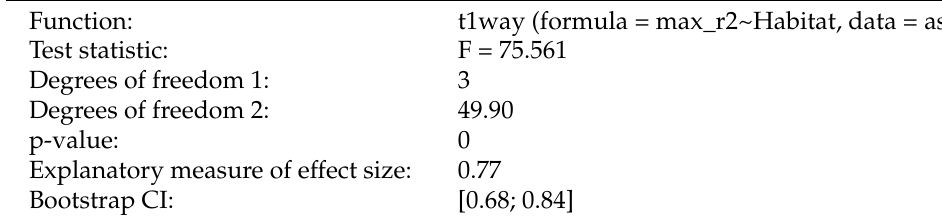
Table A2. Results of robust ANOVA one-way test from the package WRS2 [61].